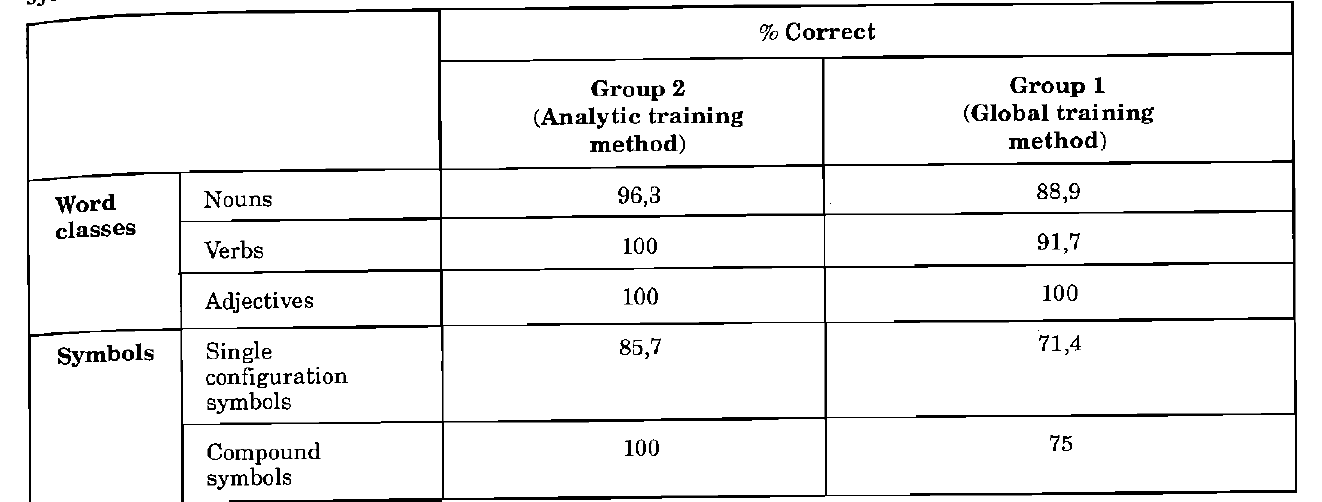
TABLE 9. An error analysis of the results obtained during the re-evaluation procedure: word classes and